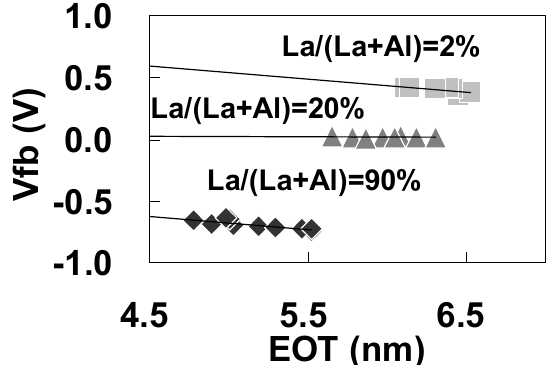
Figure 35. Dependence of Vfb on EOT for Mo/La-Al-O/SiO La/(La+Al) = 2%, 20%, and 90%. C-V measurements were performed in the direction perpendicular to the direction of La/(La+Al) variation.